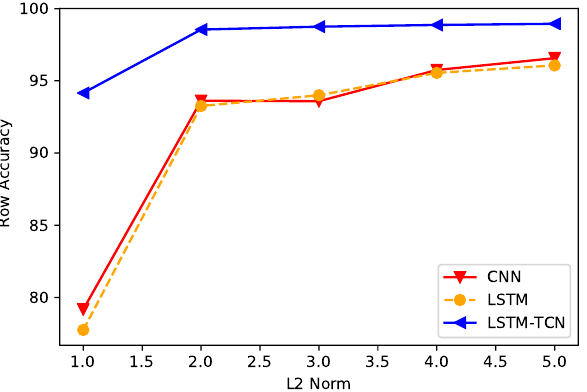
Figure 6. Presence detection accuracy versus L 2 -norm of the injection data in IEEE 118-bus